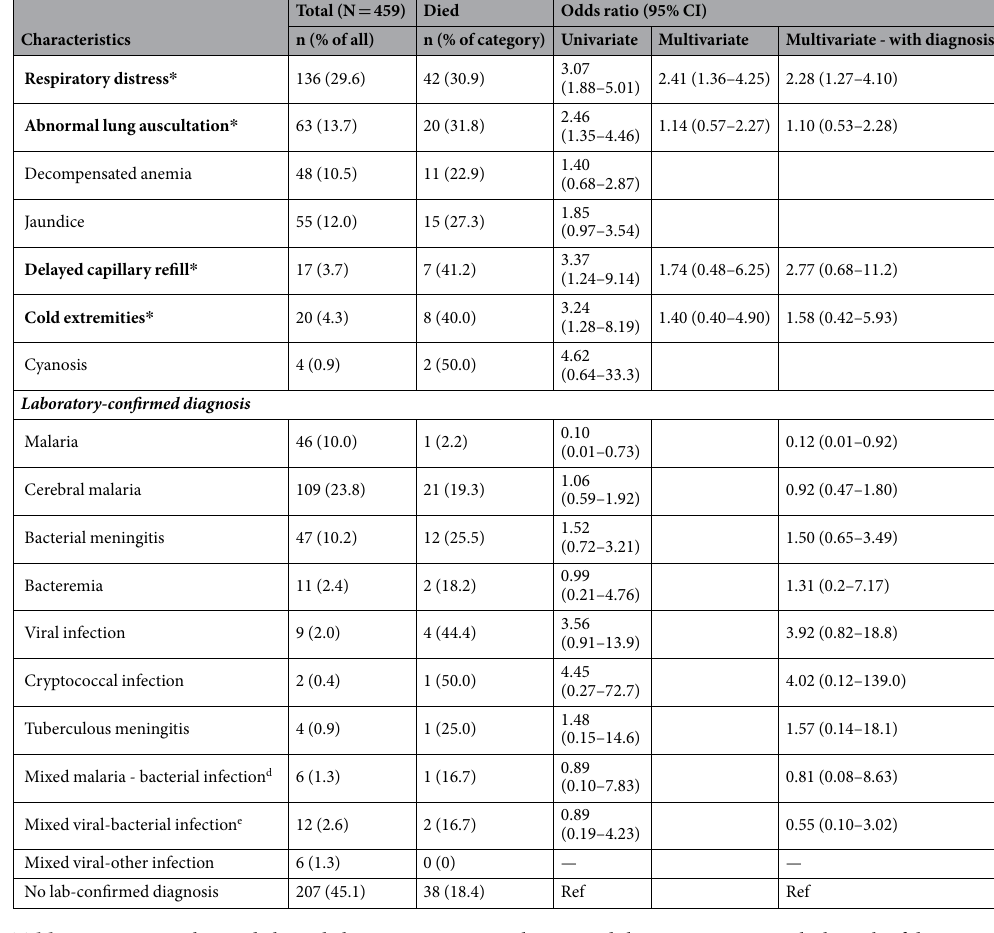
Table 2. Demographic and clinical characteristics on inclusion and their association with the risk of dying during hospitalization, univariate and multivariate analyses (including or not laboratory-confirmed diagnoses). 95% CI: 95% confidence interval; * Variables associated with a higher risk of death in univariate analysis and included in the multivariate analysis. a Moderate malnutrition was defined as a weight for height z-score between − 2 and − 3 and severe malnutrition was defined as a weight for height z-score < − 3 and/or bipedal edema; b Criteria reported as “not applicable” (due to age groups) or “don’t know” (eg. headache in infants or unconscious child) were considered as negative. c Reduced consciousness was defined as a Blantyre coma score < 4 in children < 9 months, Blantyre coma score < 5 in preverbal children > 9 months, or Glasgow coma score < 15 in verbal children. Coma was defined as Blantyre coma score < 3 or Glasgow coma score < 11. d Including malaria and bacterial meningitis (n = 3) or bacteraemia (n = 3). e Including virus and bacterial meningitis (n = 11) or bacteraemia (n =